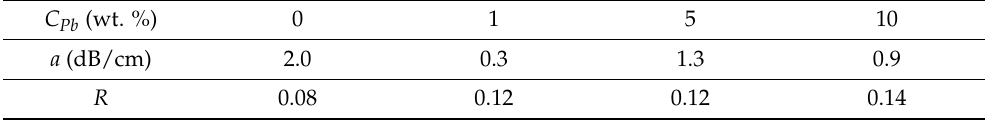
Table 15. The values of specific radio absorption a and reflection R coefficients in the microwave range for lead-containing composites at a frequency of 30 GHz.